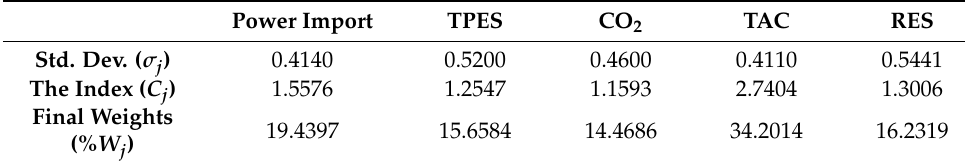
Table 6. σ j , Cj and final weights of the criteria.